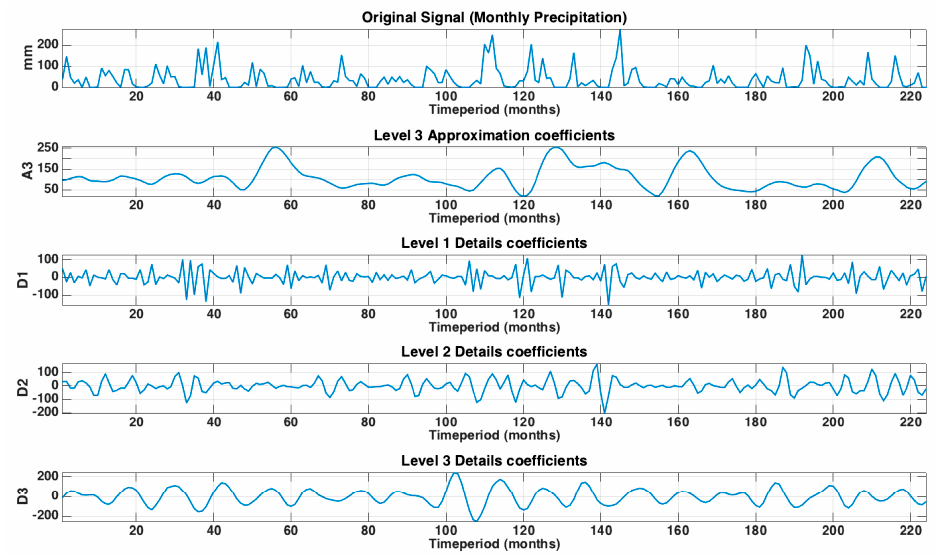
Figure 4. Figure 4. Original values and decomposed sub ‐ series of monthly precipitation by wavelet transformation at Málaga station (MAG01) (2001–2019).